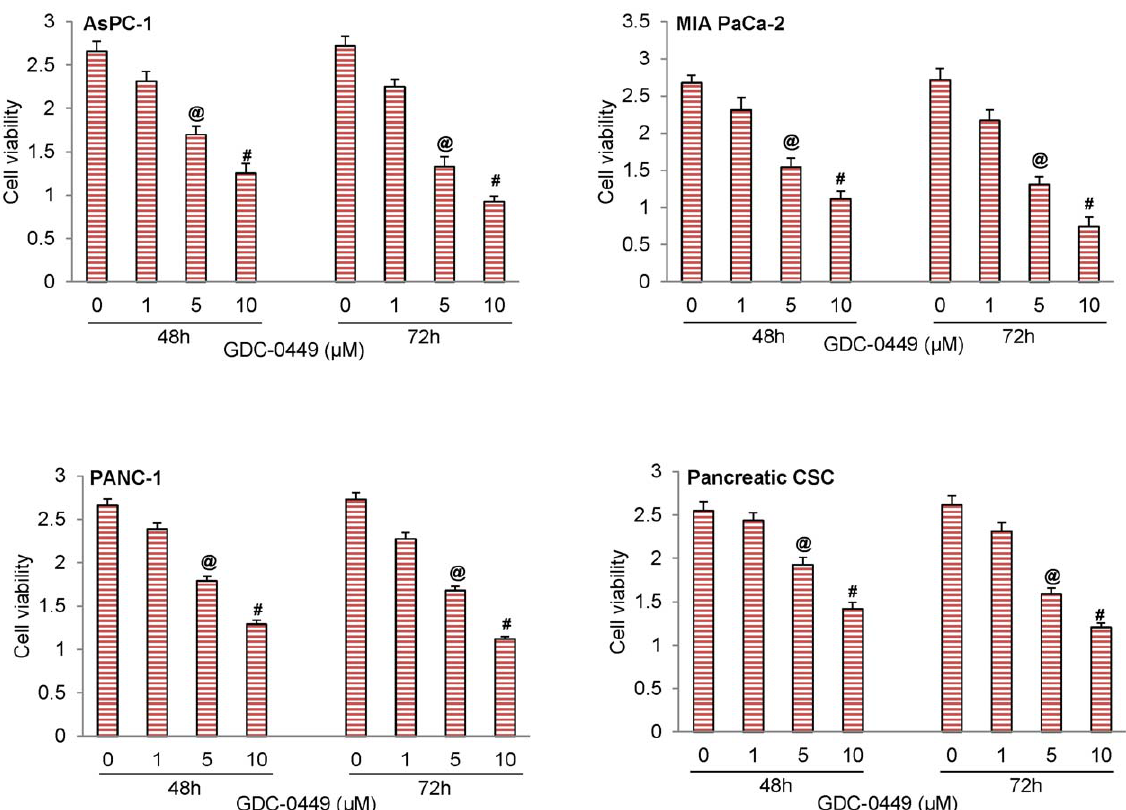
Figure 2. Inhibition of SHH signaling suppressed cell viability in human pancreatic cancer cell lines and pancreatic CSCs by GDC- 0449. Cells were treated with GDC-0449 (0, 1, 5 and 10 m M) for 48 and 72 h. At the end of incubation period, cell viability was measured by XTT in (A) AsPC-1, (B) MIA PaCa-2, (C) PANC-1, and (D) Pancreatic CSCs. Data represent mean 6 SD. @ or # significantly different from respective control (P , 0.05).